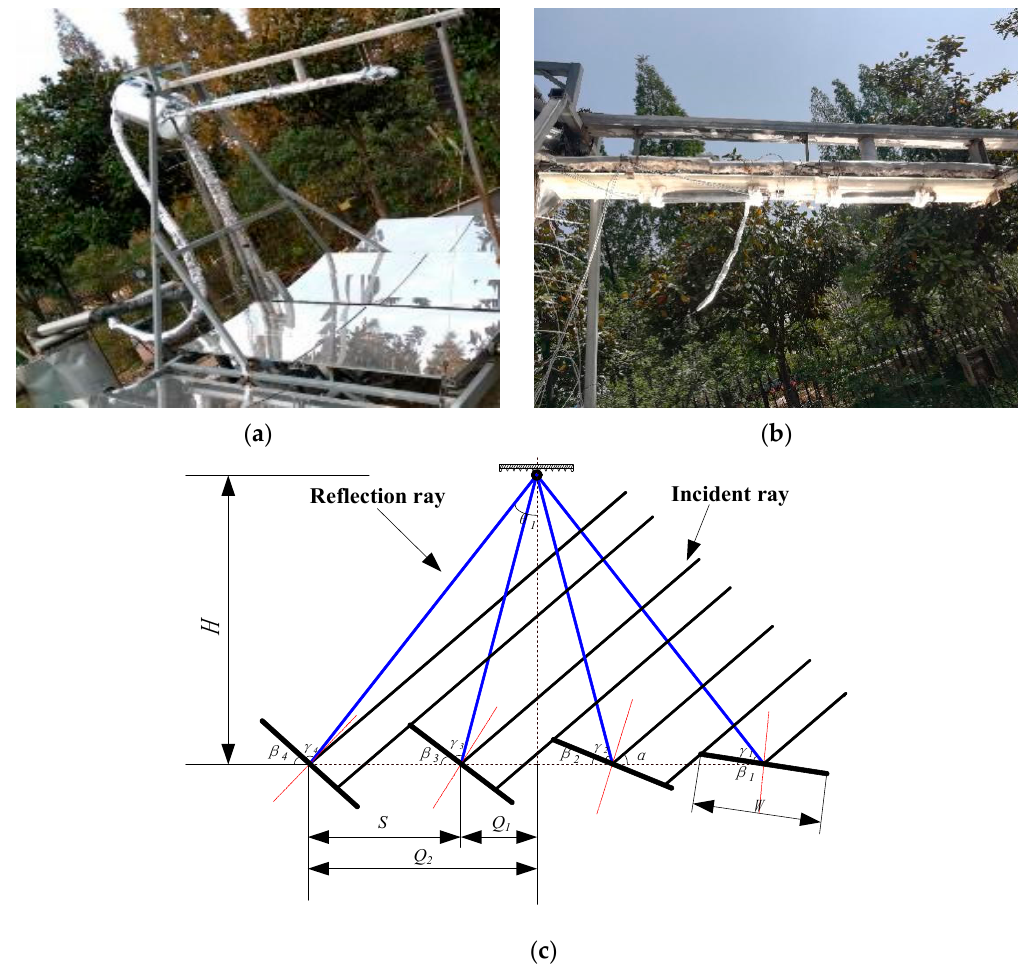
Figure 12. Linear Fresnel solar collector: ( a ) overview image; ( b ) solar evacuated tube with nanofluids; ( c ) schematic diagram. Table 5. Parameters of the Fresnel solar collector.